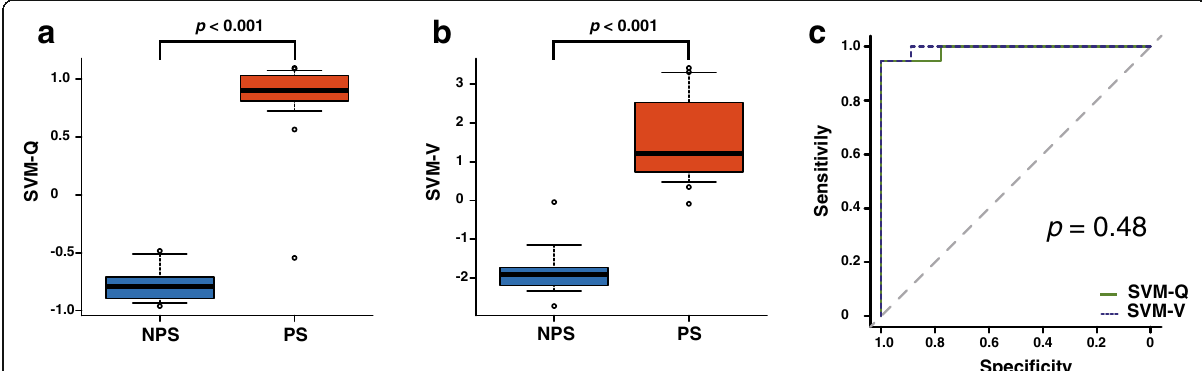
Fig. 5 Box-and-whisker plots and ROC analysis of SVM-Q and SVM-V. There were significant differences between NPS and PS in both the SVM-Q ( a ) and SVM-V ( b ), as assessed using a Mann-Whitney U test. c The AUCs for the SVM-Q and SVM-V were 0.988 and 0.994, respectively. Abbreviations: AUC, area under the curve; NPS, non-parkinsonian syndrome; PS, parkinsonian syndrome; ROC, receiver-operating characteristics; SVM, support vector